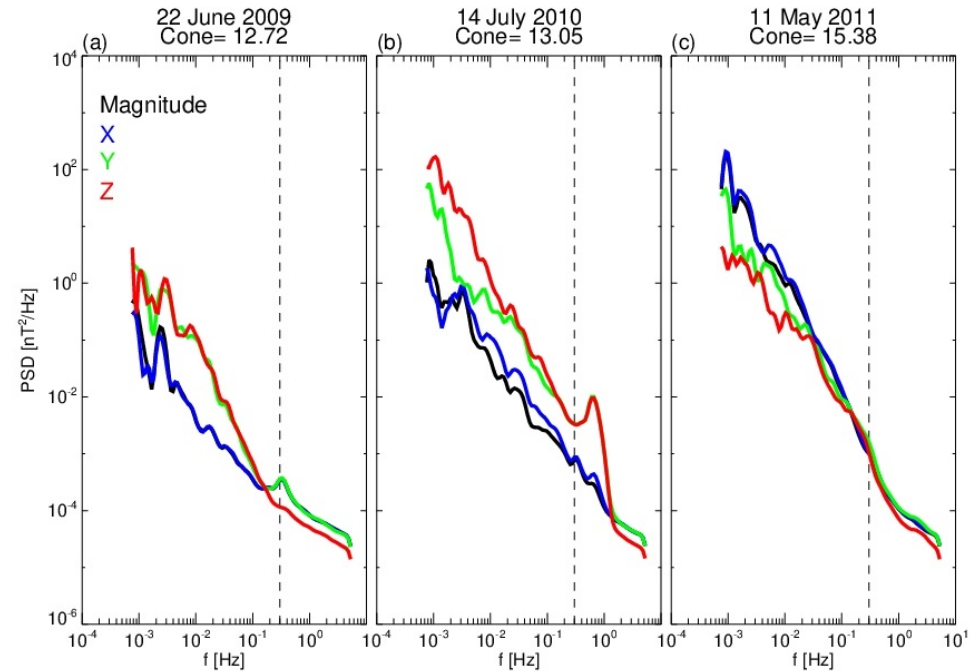
Figure 2. Three typical types of PSD profiles of magnitude and three components of the magnetic field (black for magnitude, blue for B X , green for B Y , red for B Z ) in the radial IMF events. The dashed lines denote the spin rate of the Wind spacecraft. ( a ) data from 22 June 2009, ( b ) data from 14 July 2010, ( c ) data from 11 May 2011.